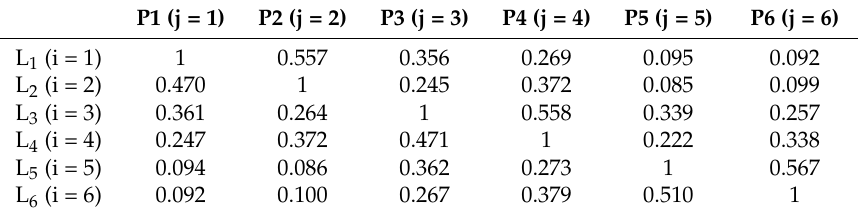
Table 2. Proportion of workplane illuminance by distant luminaires ( IE ij ).